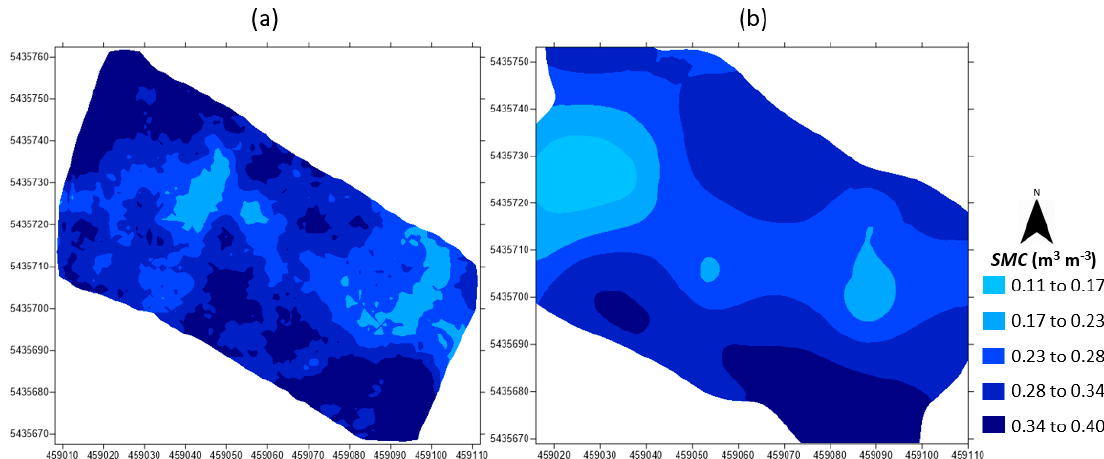
Figure 8. Spatial variability maps of SMC for the large field study estimated using EC a -L measurements ( a ) and 27 geo-referenced point measurements using the HD2-TDR ( b ).